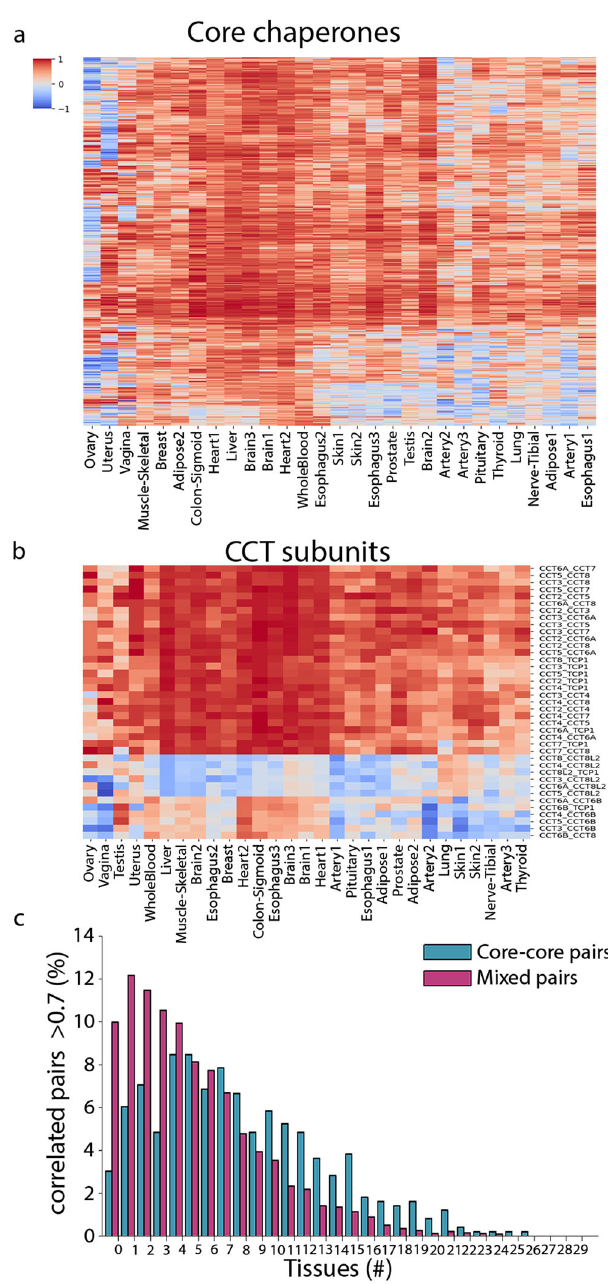
between aging and the brain-speci fi c chaperone network, we relied on a large-scale analysis of chaperone expression in aging brains 37 . There, pairs of chaperones with highly correlated expression in aging brain were identi fi ed, and the expression of each chaperone was tested for its correlation with age. To examine whether the functional relationships between chaperones were conserved in aging, we compared between highly correlated pairs observed in adult brain and in aging brain. We found a highly signi fi cant overlap between them (265 pairs, p = 1.4E − 32, Fisher exact test, Fig. 6c). Most of the overlapping pairs were highly correlated only in brain and not in other tissues (167/265 pairs, Fig. 6c). Moreover, overlapping pairs belonged primarily to modules that were repressed in aging brain 37 (258/265). This suggests that a brain-speci fi c chaperone network is conserved across time and is repressed with age.